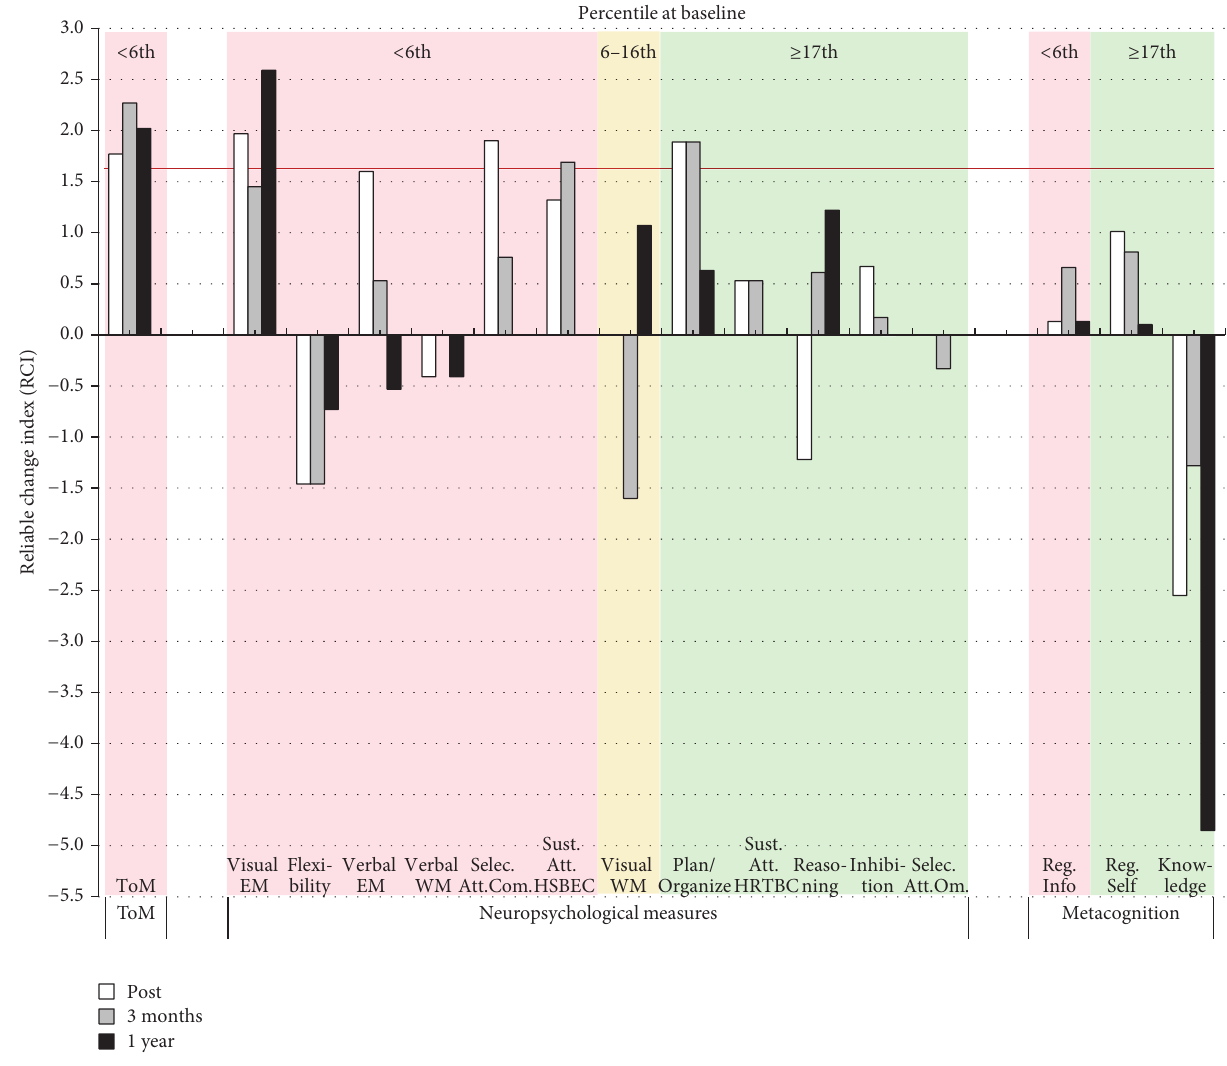
Figure 3: Changes in ToM and neuropsychological and metacognitive results for Case B for each of the follow-up assessments (posttreatment, 3 months and 1 year after treatment). The color of the background indicates the severity of the deficit at baseline. A red background indicates a severe impairment at baseline ( ≤ 6th percentile), a yellow background indicates an important impairment (7th to 16th percentile), and a green background indicates a normal performance ( ≥ 17th percentile). The horizontal red line indicates the statistical RCI threshold of 1.64. ToM = theory of mind; EM = episodic memory; WM = working memory; selec. att. = selective attention; com. = commission; sust. att. = sustained attention; HSBEC = Hit Standard Error Block Change; HRTBC = Hit Reaction Time Block Change; om. = omission; reg. info = Metacognitive Regulation Informant Report; reg. self = Metacognitive Regulation Self Report; knowledge = metacognitive